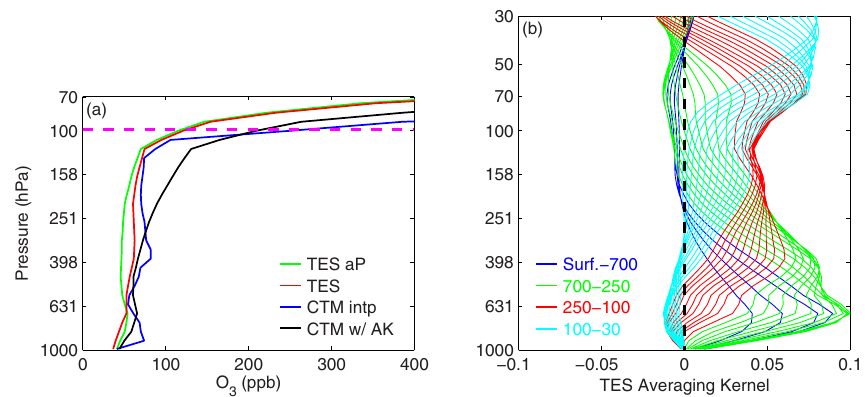
Fig. 1. Comparisons between TES a priori (green), TES (red), linearly interpolated CTM on TES levels (blue) and convolved CTM (black) ozone profiles ( a , unit: ppb) and the corresponding TES averaging kernel (AK, b ) as a function of pressure at 9.5 ◦ S, 295.0 ◦ E on 25 August 2005. In panel (a) , dashed magenta line shows the e90 tropopause of 99hPa. The AK for different pressure ranges are represented by solid lines in (b) : blue for surface–700hPa, green for 700–250hPa, red for 250–100hPa, and cyan for 100–30hPa. The dashed black line in (b) shows the zero line. The DOFS for the troposphere and the whole atmosphere are 1.5 and 4.0, respectively.